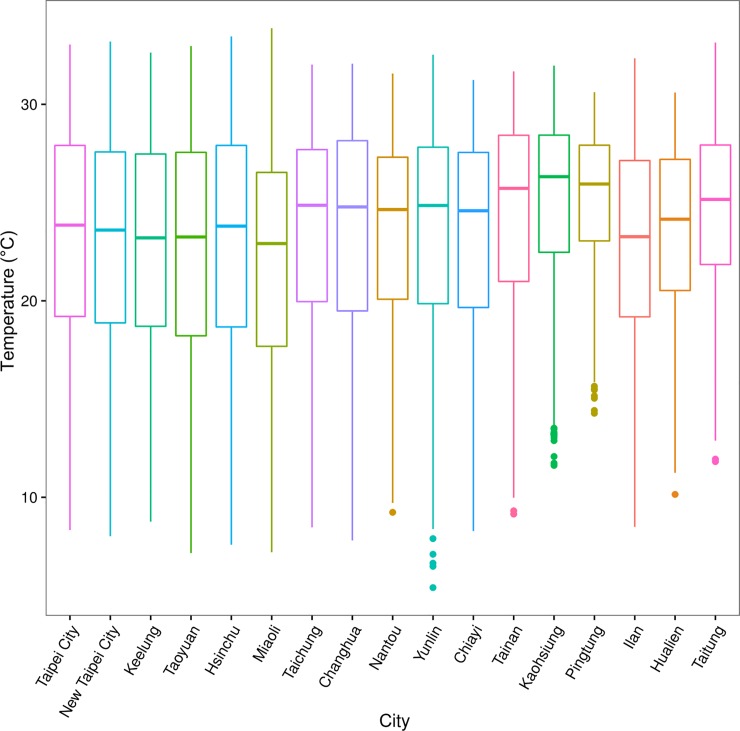
Boxplot of daily average temperature by study area in Taiwan.